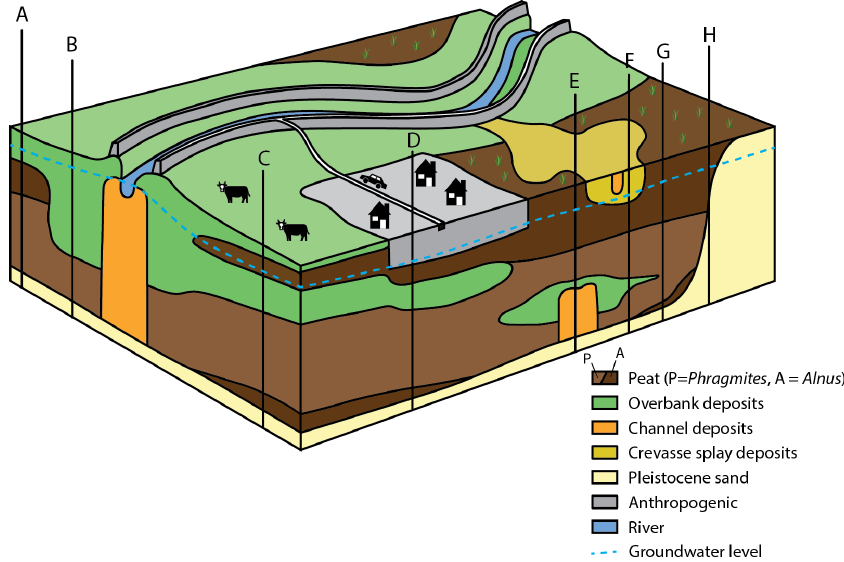
Figure 2. Schematic representation of the lithological subsurface composition of the distal (western) part of the Holocene Rhine-Meuse delta. The vertical lines (A–H) indicate different sequences with a varying potential for subsidence due to compaction and oxidation depending on the subsurface composition and